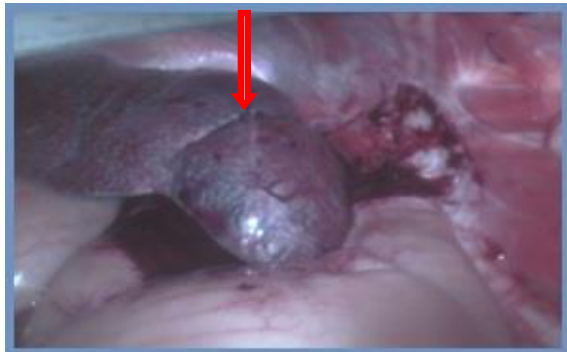
Figure, 3: The interrupted horizontal mattress suture was applied around the splenic resected part ( red arrow ) in group A